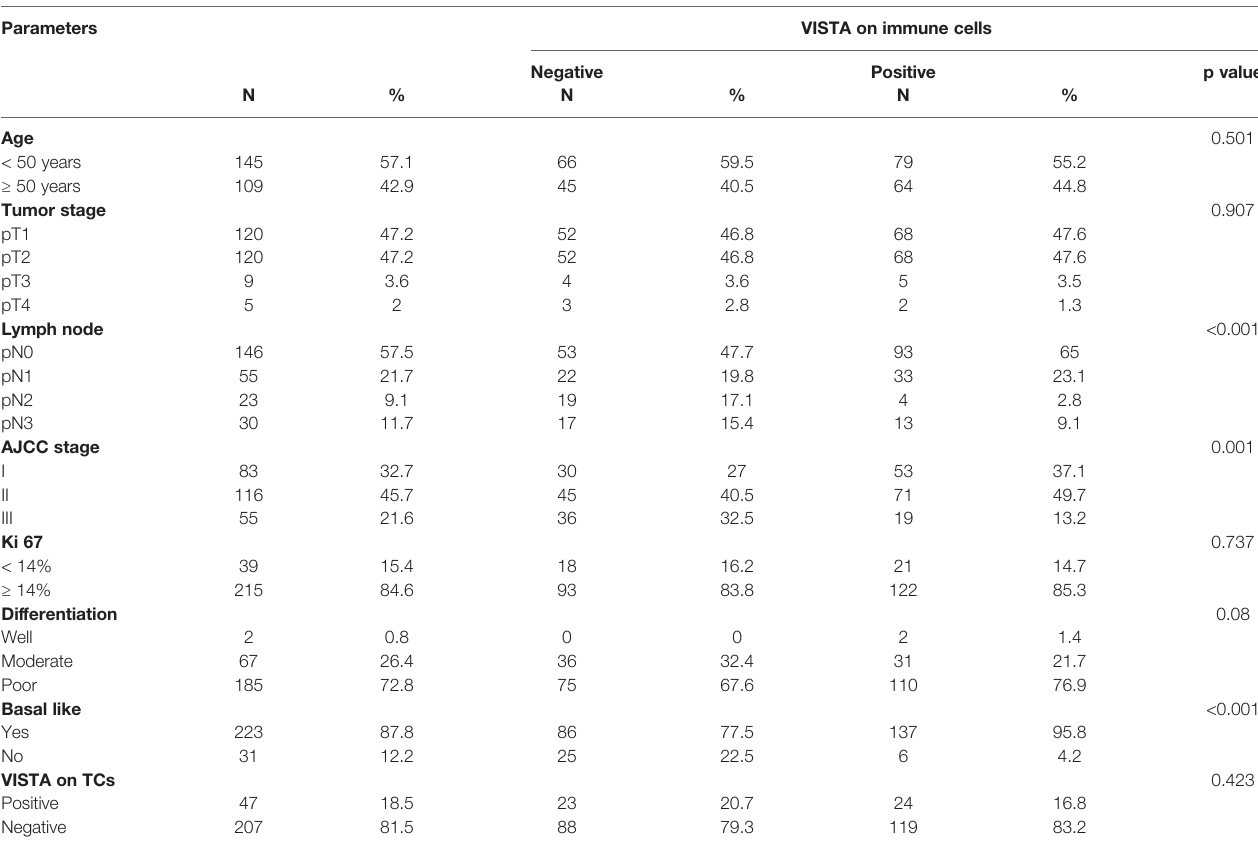
TABLE 1 | VISTA on immune cells and clinicopathological characteristics in TNBC. Parameters VISTA on immune cells Negative